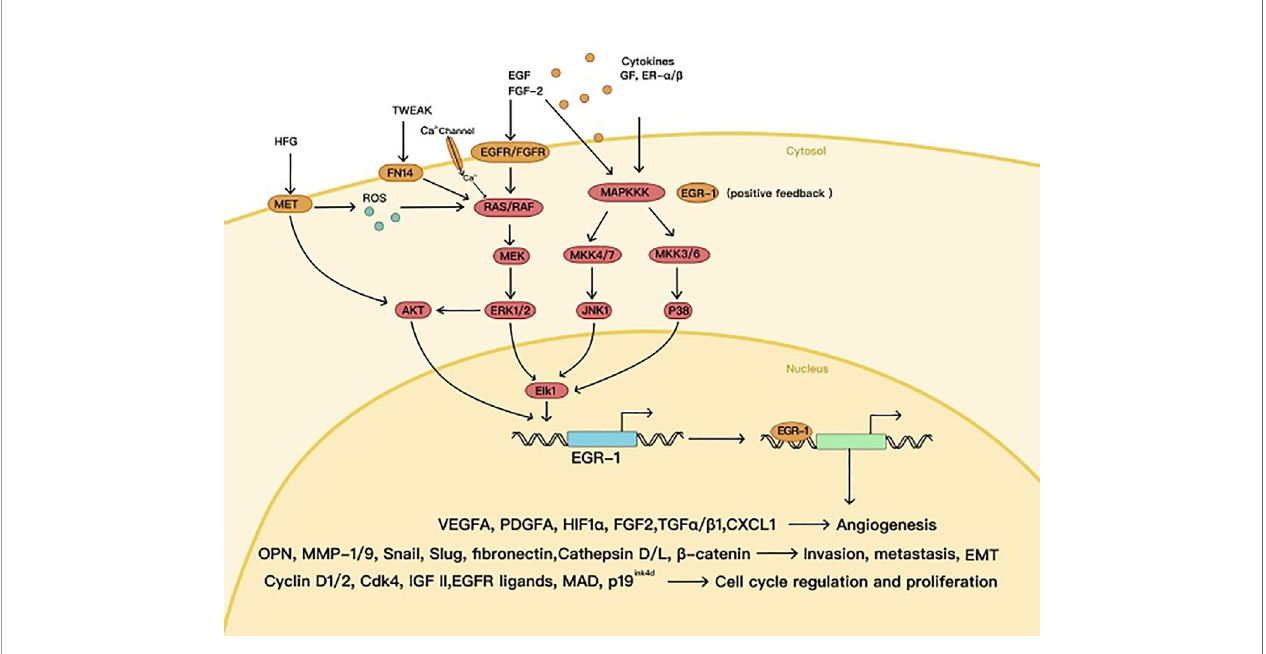
FIGURE 2 | The oncogenic effects of